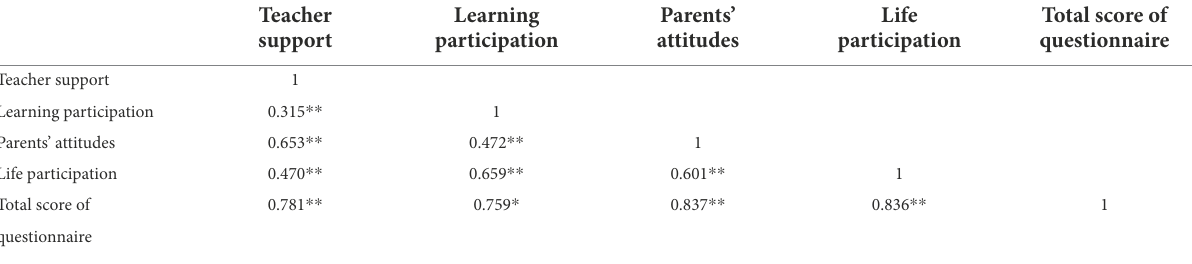
TABLE 6 Correlation between dimensions of the questionnaire and the total score.